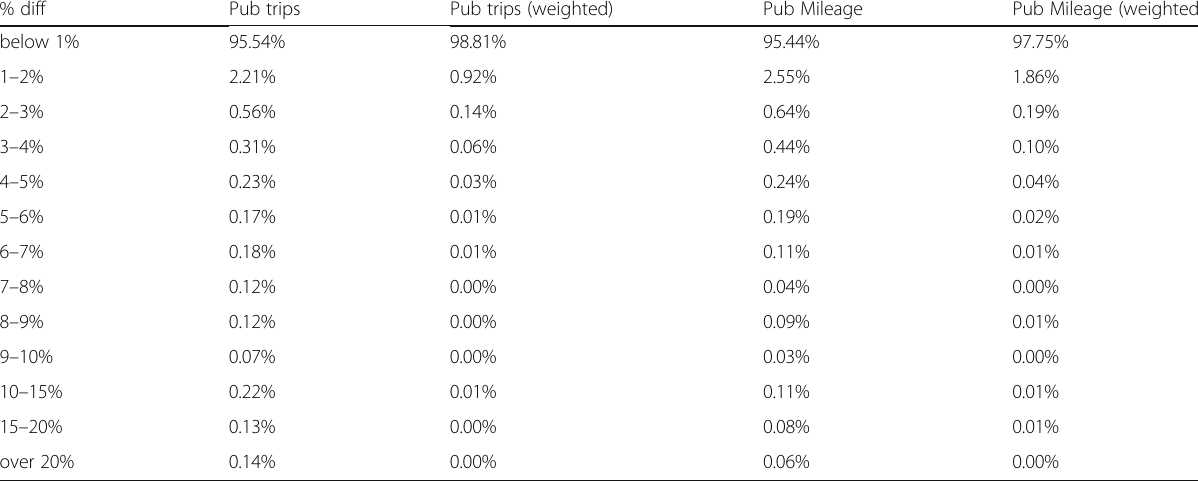
Table 13 The share of origin zones where the percentage deviation is below certain thresholds for public